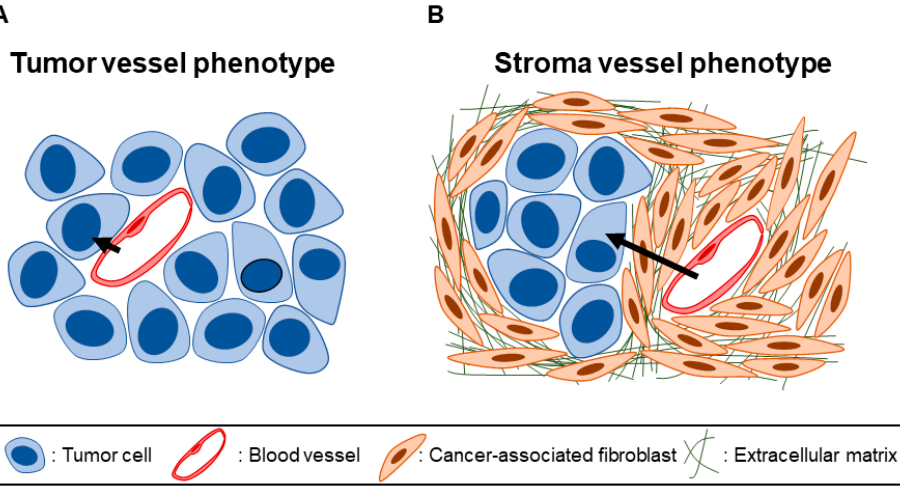
Figure 1. Tumor vessel phenotype vs. stroma vessel phenotype. ( A ) In tumor tissues with a tumor vessel phenotype, blood vessels are situated close to tumor cells with not much stromal tissue in between. ( B ) In tumor tissues with a stroma vessel phenotype, blood vessels are distanced from the tumor cells by stromal tissue. In the case of pancreatic ductal adenocarcinoma (PDAC), the stroma consists of dense, fibrotic tissue comprising cancer-associated fibroblasts (CAFs) and deposited extracellular matrix (ECM) proteins. Note the longer path (black arrows) an intravenous nanomedicine must travel to reach tumor cells in tissues with a stroma vessel, as opposed to a tumor vessel, phenotype.